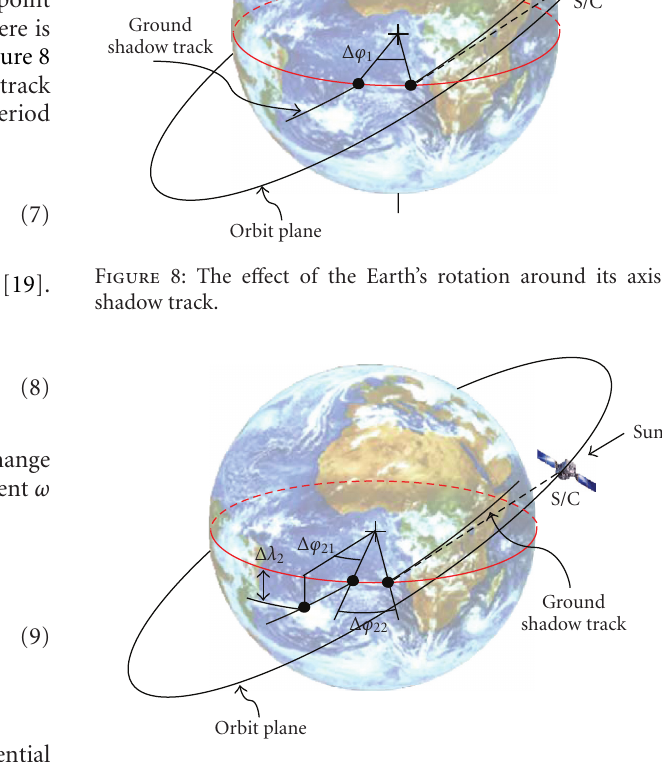
Figure 9: The e ff ect of J 2 perturbation on the ground shadow